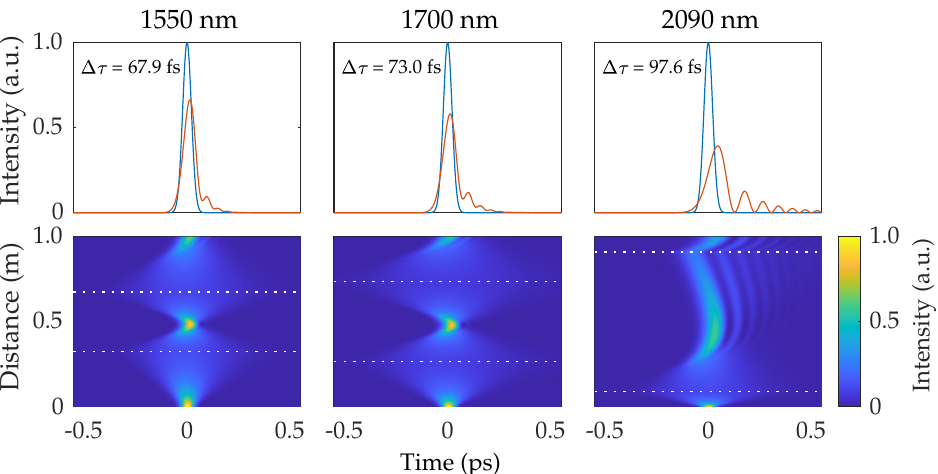
Figure 3. Top row: pulse temporal intensity before (blue) and after (red) propagation through SMF-28 and UHNA1. Bottom row: evolution of the temporal intensity profile through the system of cascaded fibers. White lines indicate transitions between different